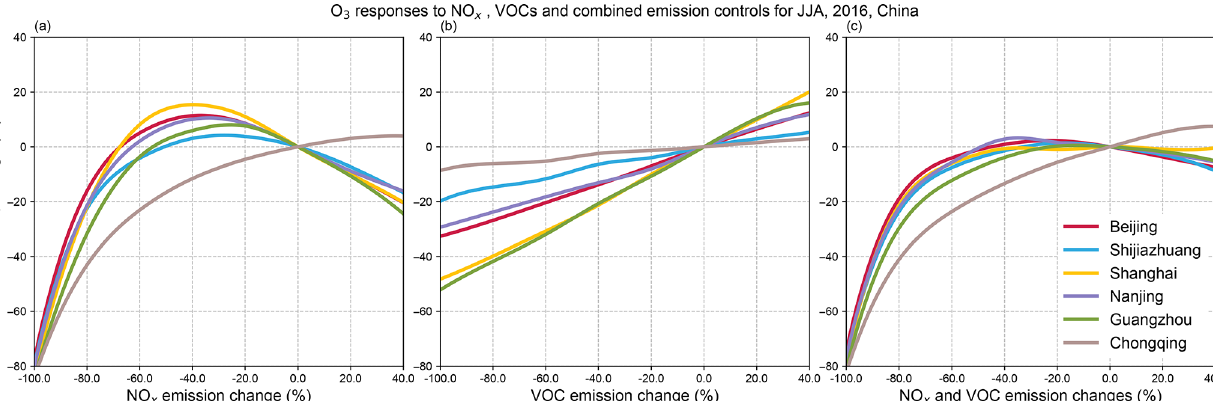
Figure 9. Simulated daytime surface O 3 responses to changes in anthropogenic emissions of (a) NO x , (b) VOC, and (c) combined NO x and VOC emissions for the six industrial regions in JJA, 2016, China.